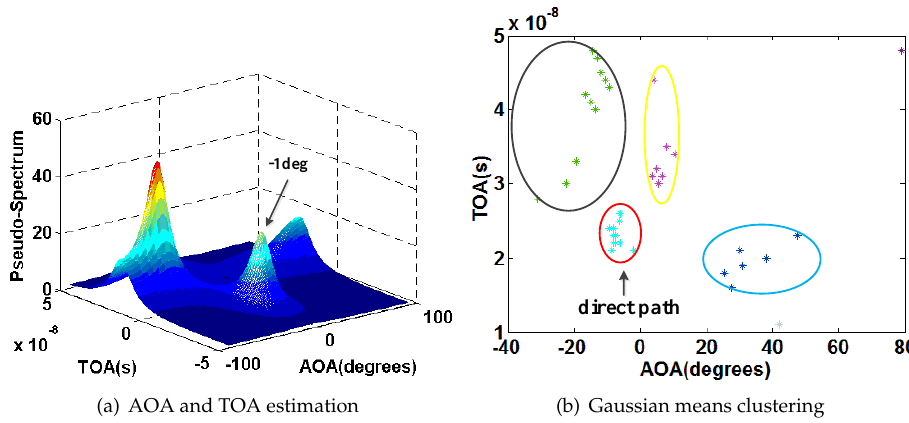
Figure 17. Results of AOA and TOA estimation and the related Gaussian means clustering at the